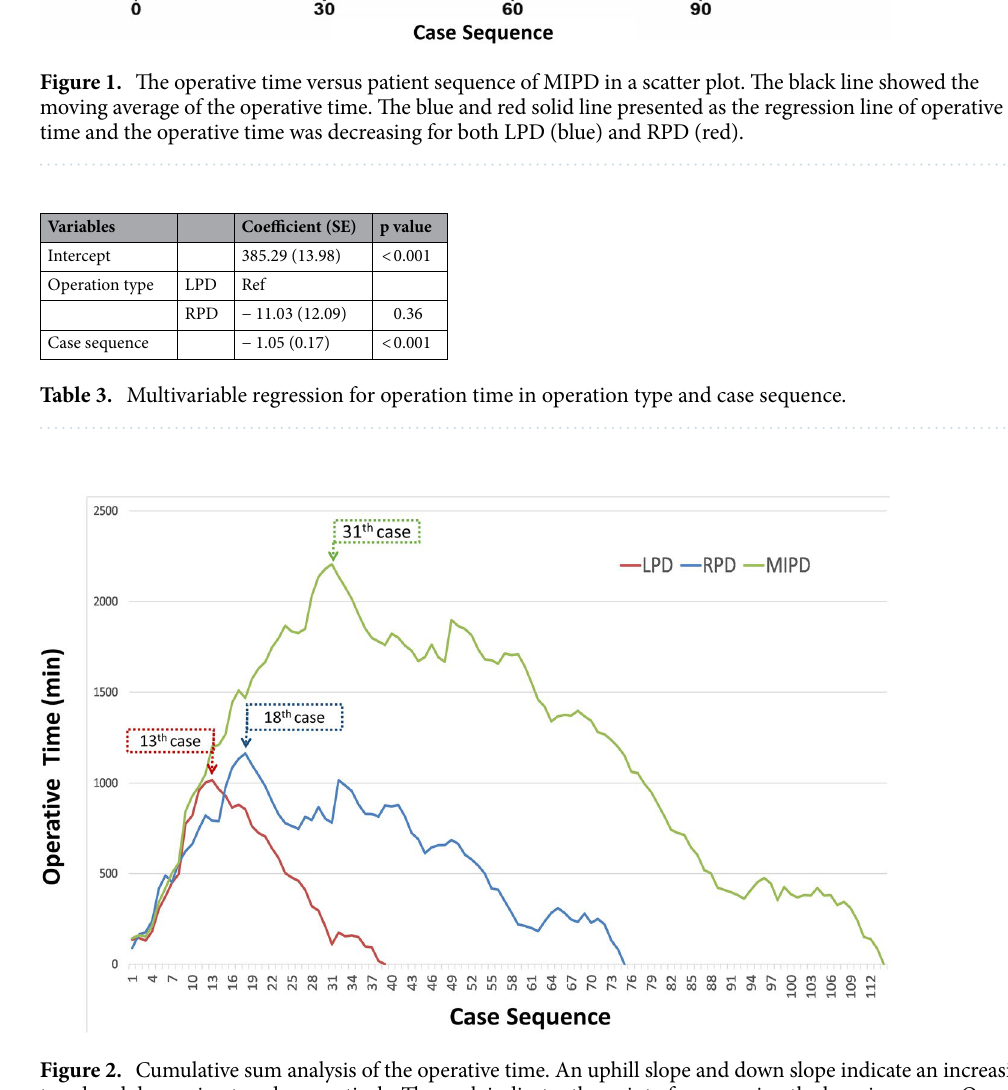
Figure 2. Cumulative sum analysis of the operative time. An uphill slope and down slope indicate an increasing trend and decreasing trend, respectively. The peak indicates the point of overcoming the learning curve. Overall, 13, 18, and 31 patients are required to be proficient in LPD, RPD, and MIPD,